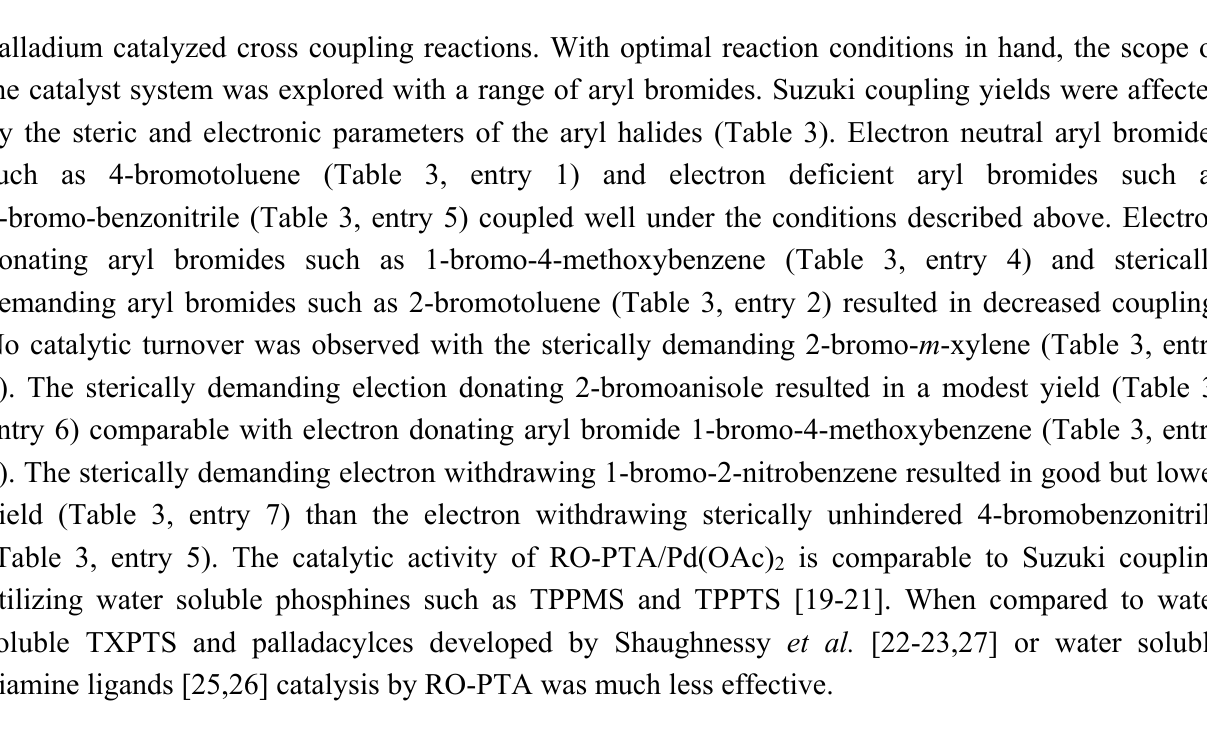
Table 3. Coupling of aryl halides with phenylboronic acid catalyzed by RO-PTA/Pd(OAc)